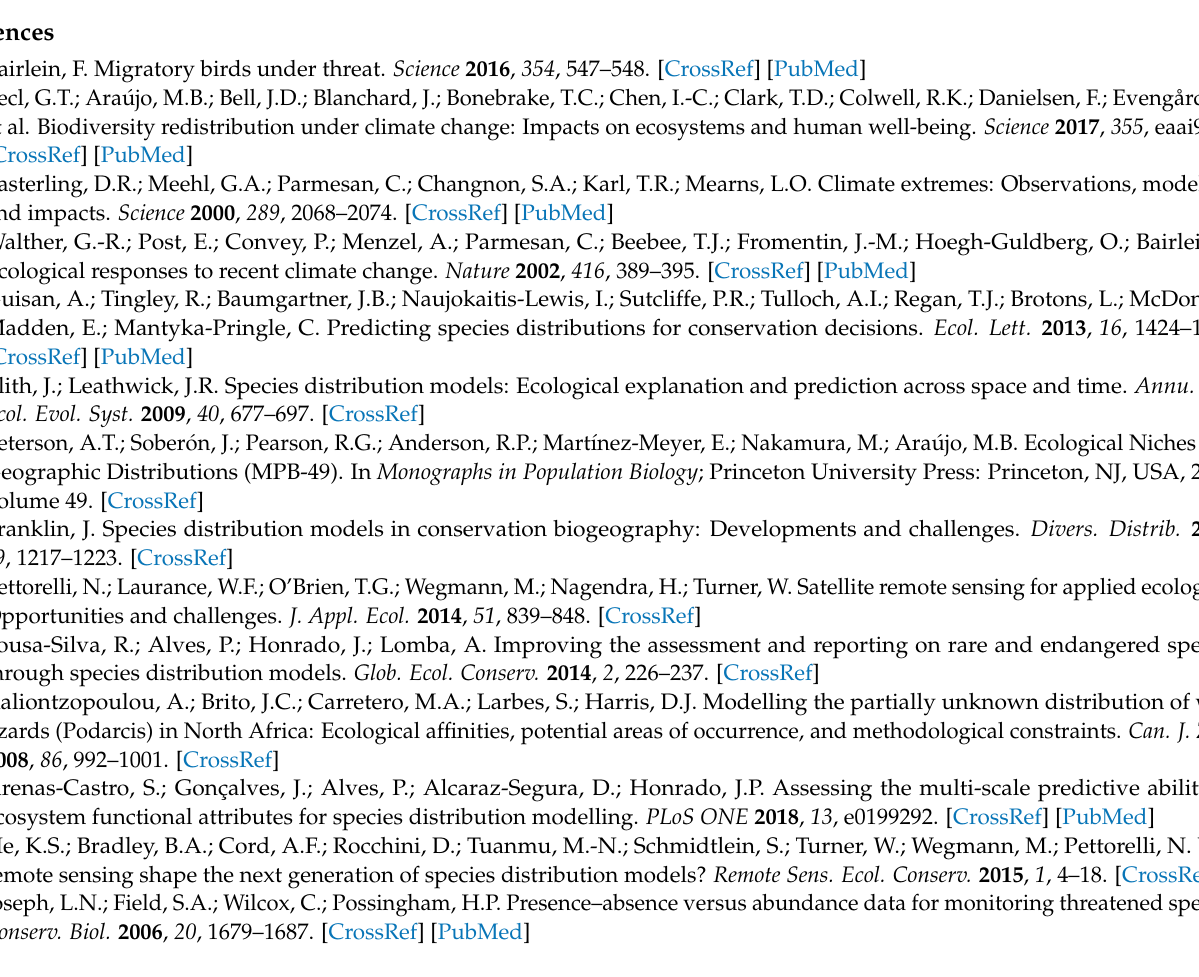
Figure A3. Model performance for the wintering period, obtained with the R package “perfor- mance” [78].